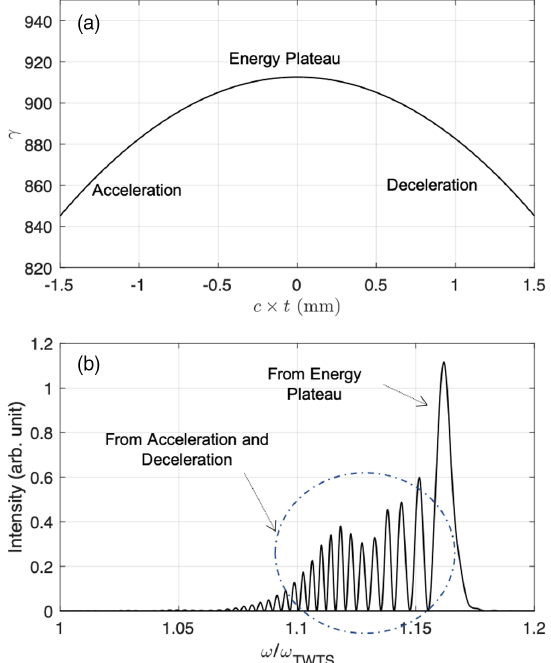
FIG. 3. A relativistic electron is continuously diagnosed with TWTS for its spectrum when it is in a laser wakefied accelerator and near the dephasing limit. (a) An electron accelerated by the wakefied to an energy plateau, before a decrease takes place due to the dephasing of the acceleration. (b) Electron TWTS spectrum contains a continuum which corresponds to the electron energy continuum. Simulation parameters can be found in Table